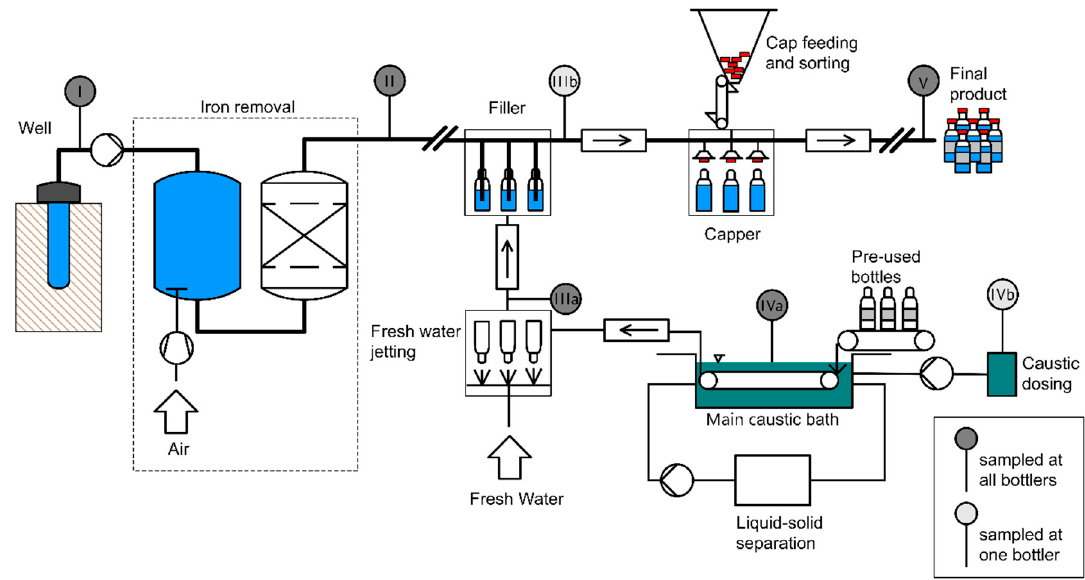
Figure 1. Schematic representation of water bottling and sampling locations: (I) raw water, (II) deferrized filtered water, (IIIa) cleaned glass bottles, (IIIb) filled glass bottles, (IVa) caustic cleaning solution, (IVb) caustic concentrate, (V) filled and capped glass bottles.